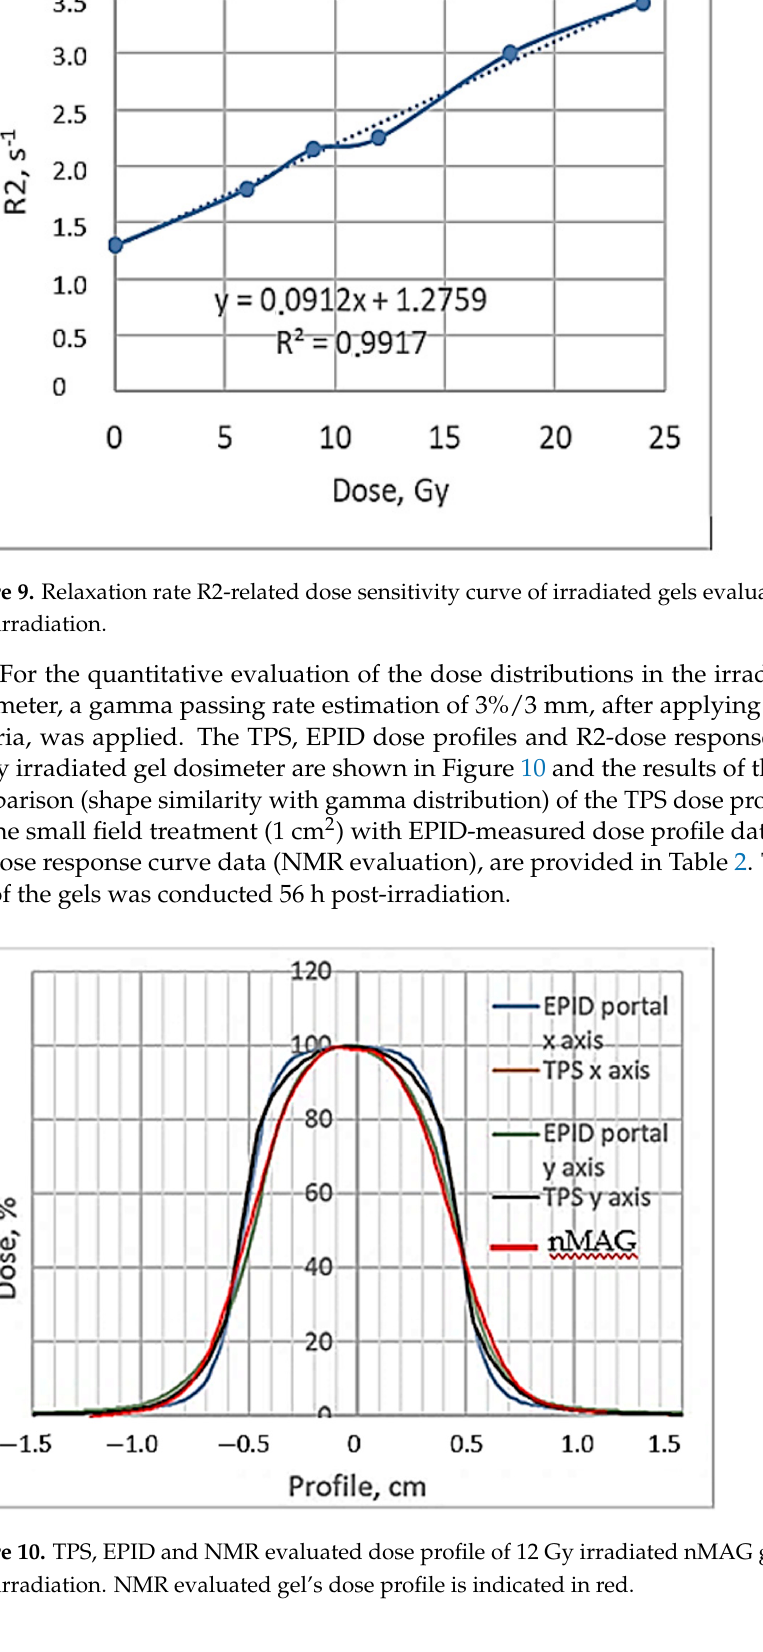
Figure 8. Dose profiles of irradiated gels evaluated by MRI 56 h post-irradiation .